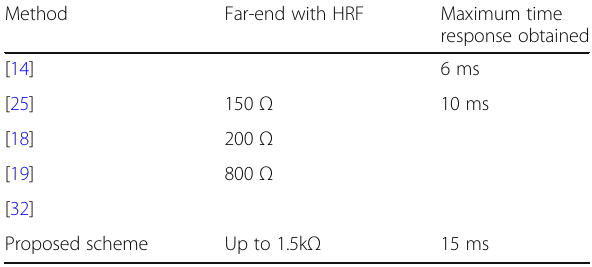
Table 8 Comparative assessment with previous work